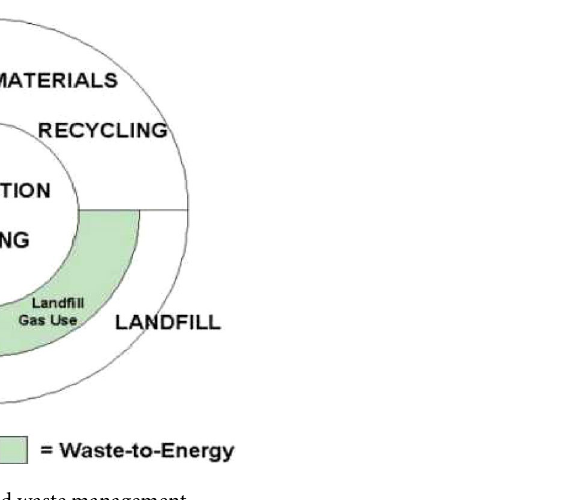
Figure 2. Elements of integrated solid waste